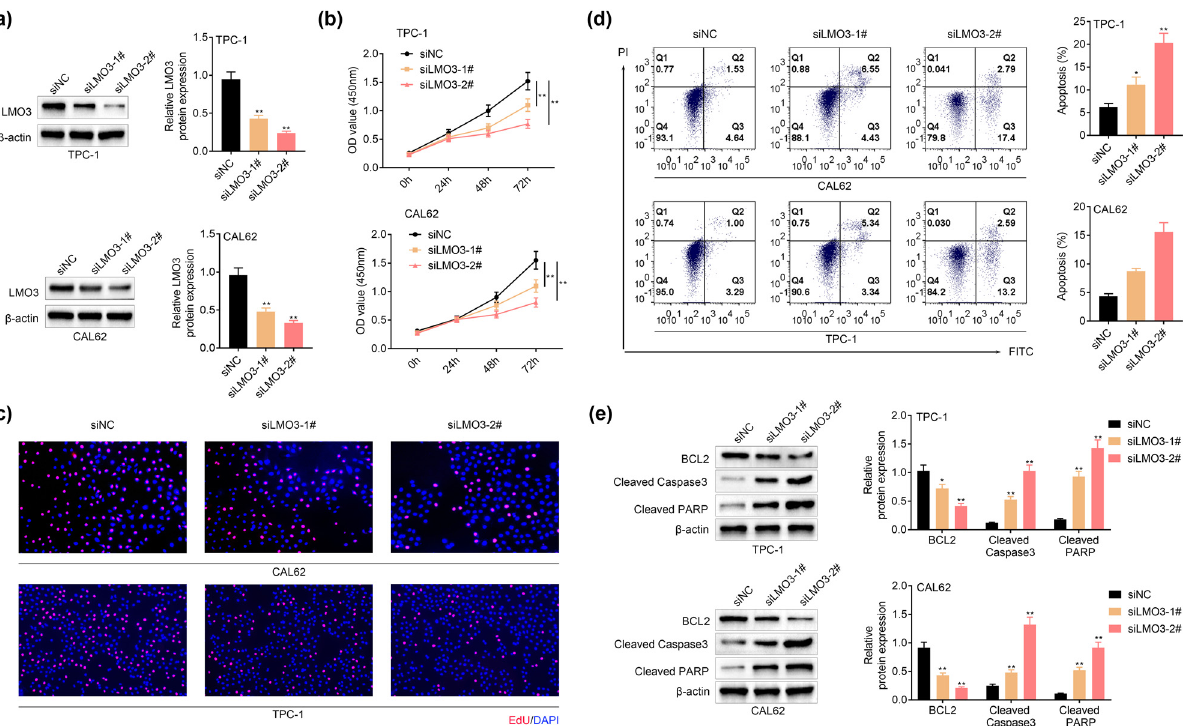
Figure 2: LMO3 promoted PTC cell proliferation. ( a ) LMO3 protein expression was downregulated in the PTC cell lines ( TPC - 1, CAL62 ) by transfection with siLMO3 - 1# and 2#. Knockdown of LMO3 ( b ) decreased cell viability of TPC - 1 and CAL62, ( c ) reduced the cell proliferation of TPC - 1 and CAL62, ( d ) promoted the cell apoptosis of TPC - 1 and CAL62, and ( e ) enhanced protein expression of cleaved caspase - 3 and cleaved PARP and reduced Bcl - 2 in TPC - 1 and CAL62. ** vs siNC, p <